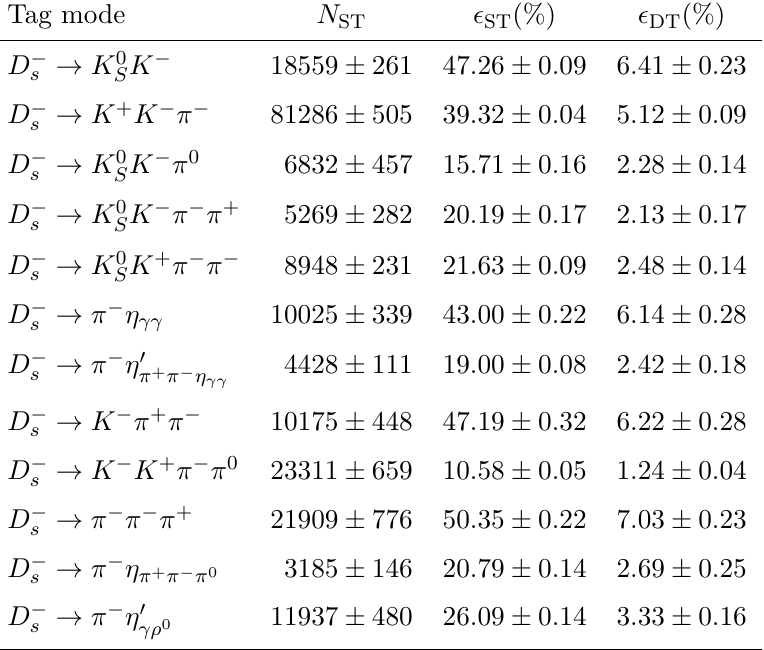
√ s = 4 . 189 − 4 . 219 GeV. The uncertainties are